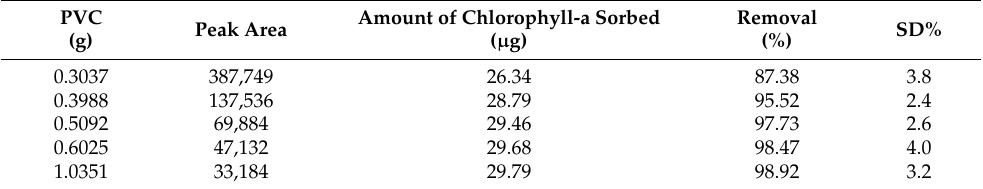
Table 2. The removal of chlorophyll-a from a solution containing 0.5 mL of spinach leaf extract, 1.5 mL of acetone, and 1 mL of deionized water by the use of different masses of PVC sorbent in the batch adsorption